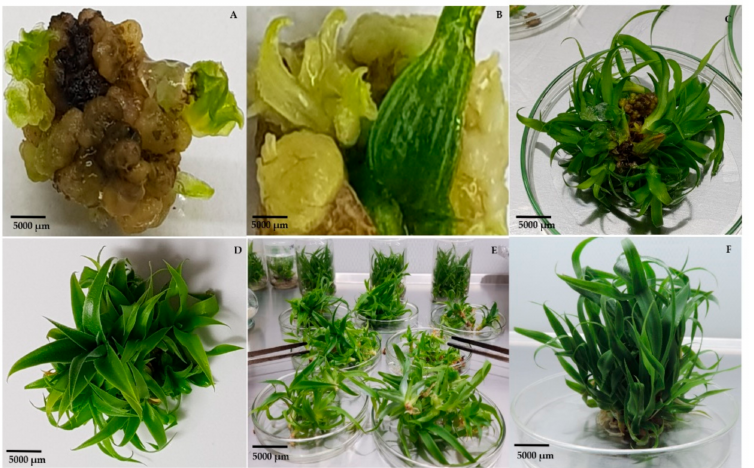
Figure 4. Efficient regeneration of pineapple shoots in the M2 treatment. ( A , B ) Rapid and abundant proliferation of neoformations with a globular structure; ( C , D ) proliferation of multiple shoots from neoformations; ( E , F ) efficient shoot